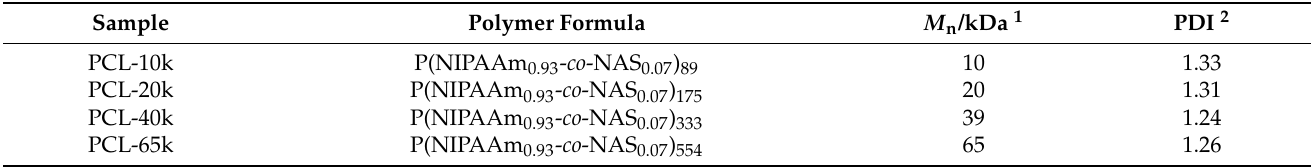
Figure 3. Synthetic scheme of the polymeric crosslinkers. Table 2. Summary of the polymeric crosslinkers.